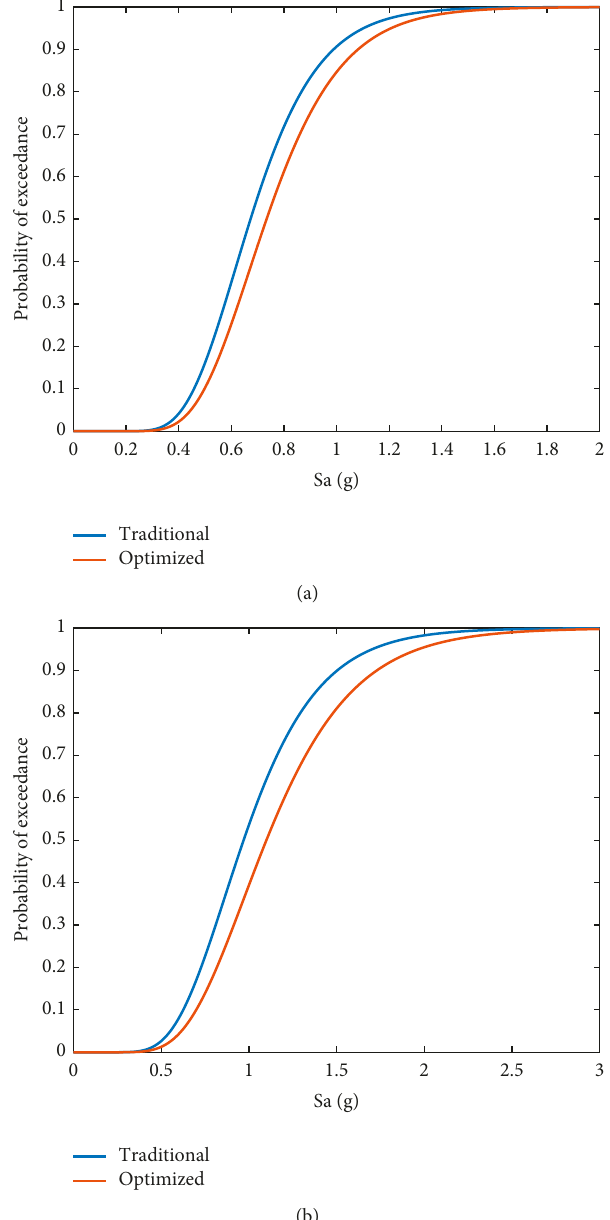
Figure 4: Results for the (a) life safety and (b) collapse fragility